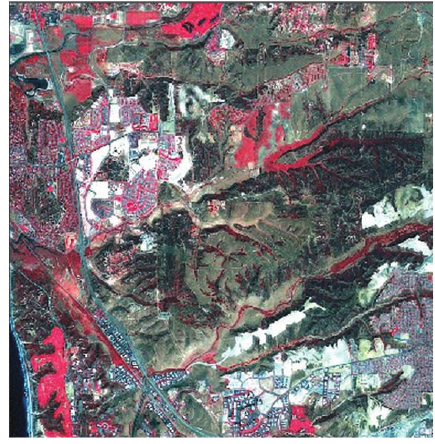
Figure 5: Image after fusion of combinatorial algorithm.